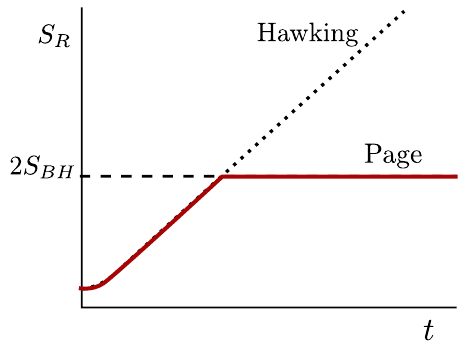
Figure 5 . Page curve for the entropy of the radiation, for the model in (cid:12)gure 3. The dotted line is the growing result given by the Hawking computation, and the entropy calculated from the other saddle is dashed. The minimum of the two is the Page curve for this model.